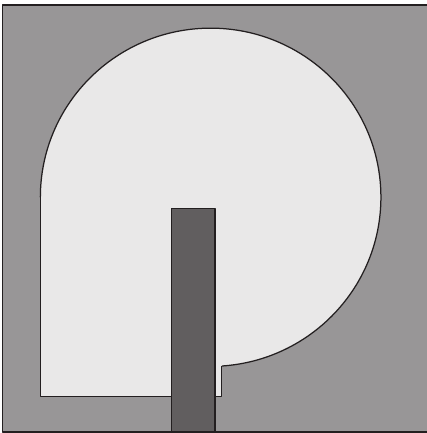
Figure 27: A compact UWB p-shaped wide-slot antenna for cancer detection [90]. Dark gray upper metal face, medium gray bottom metal face, and light gray dielectric